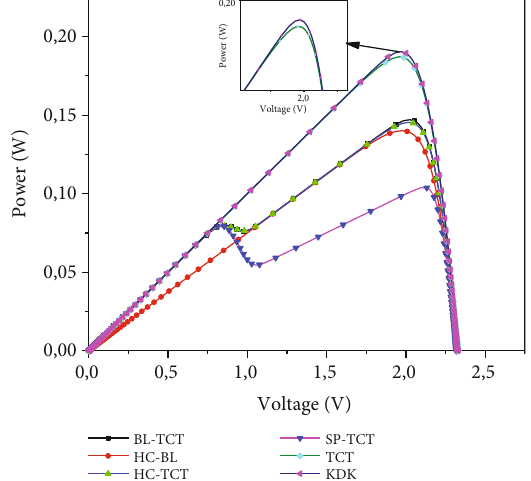
Figure 11: P-V characteristics of various PV module topologies operating in diagonal shading